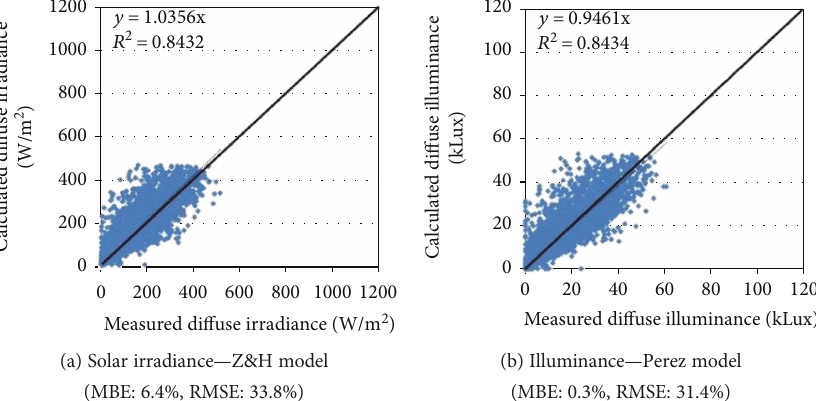
Figure 2: Scatter plotting of di ff use solar radiation and luminous e ffi cacy models performance for Lyon, France (1994).